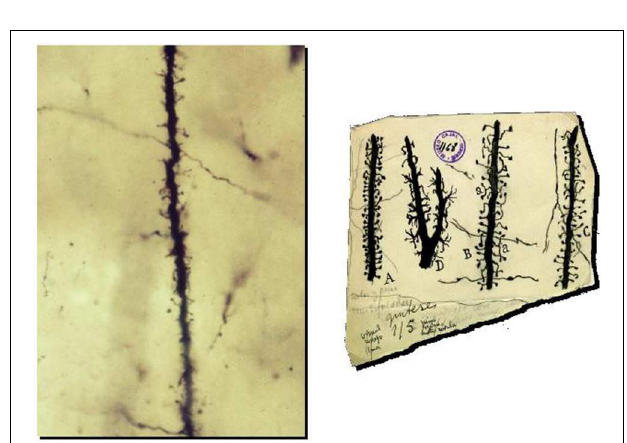
FIGURE 2 | Preparation and drawings of Cajal illustrating spines. Left: Photomicrograph of a dendrite of pyramidal neuron from one of Cajal’s original preparations (Courtesy of Cajal Institute in Madrid). Right: Cajal drawings of spines from rabbit (A), 2 month old child (B), one month old cat (C) and cat spinal motoneuron (D). Reproduced with permission from “Herederos de Santiago Ramón y